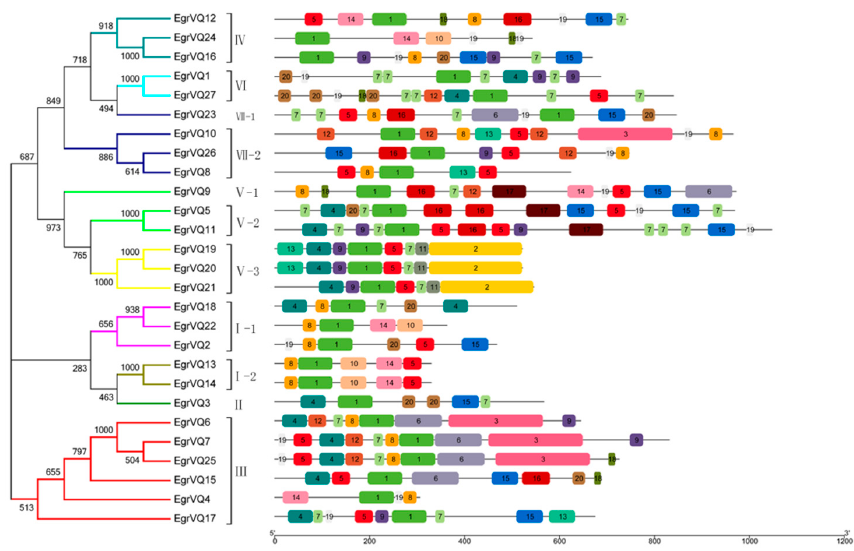
Figure 4. Gene structure of VQ genes in E. grandis . Exons were indicated by yellow rectangles. Upstream/downstream’s sequences of EgrVQs were indicated by blue lines. Gray lines connecting two exons represented introns.